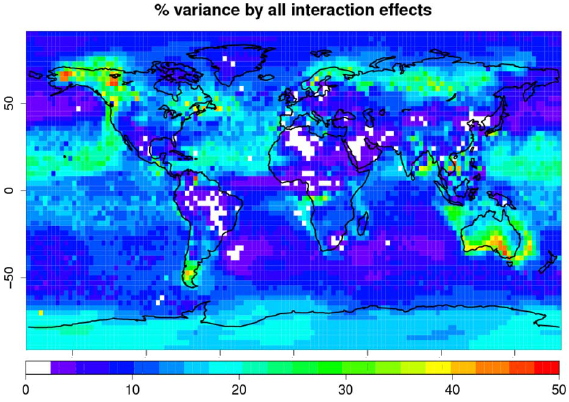
Fig. 6. Percentage of July 2000 CCN variance not explained by the main effect of the 8 parameters in Table 1. This is the variance ex- plained by the interaction of the 8 parameter uncertainties and can- not be captured using OAT